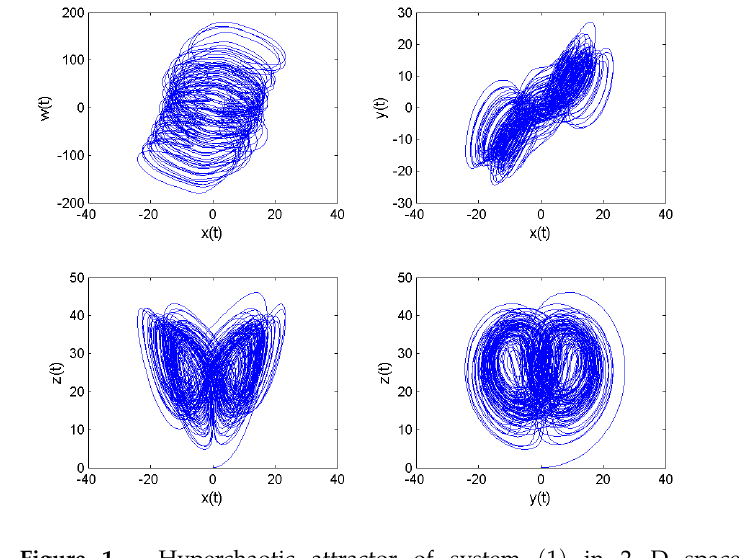
Figure 1. Hyperchaotic attractor of system ( 1 ) in 2 − D spaces with ( a , b , c , d , e , r ) = (cid:18) (cid:19) 8 10, 3,28, − 1,10,3 and initial condition ( x 0 , y 0 , z 0 , w 0 , υ 0 , u 0 ) = ( 0.1,0.1,0.1,0.1,0.1,0.1 )